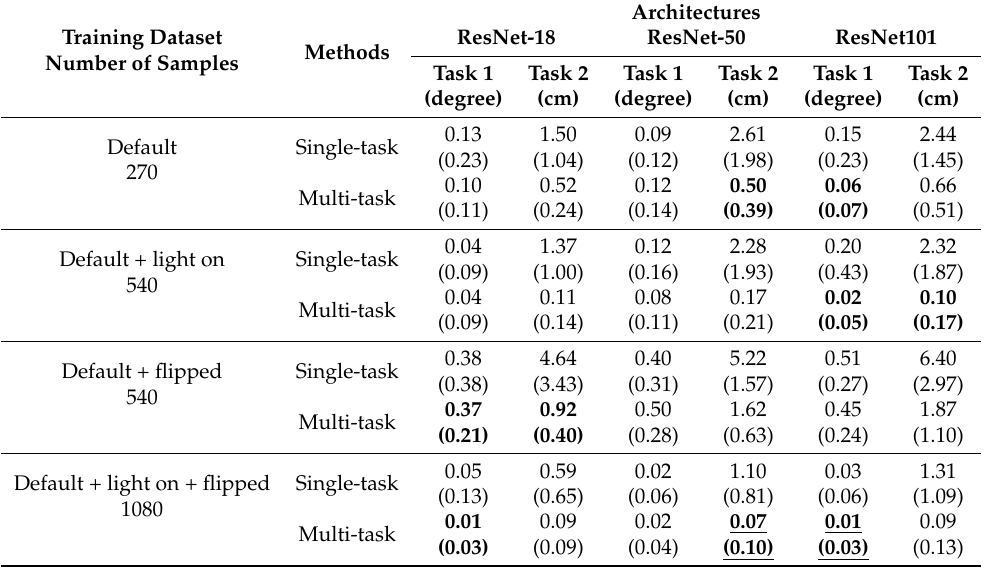
Table 8. Comparisons of results using the different training datasets, in terms of mean absolute error. The best values for each architecture are in bold and the best performing model among the architectures is underlined.